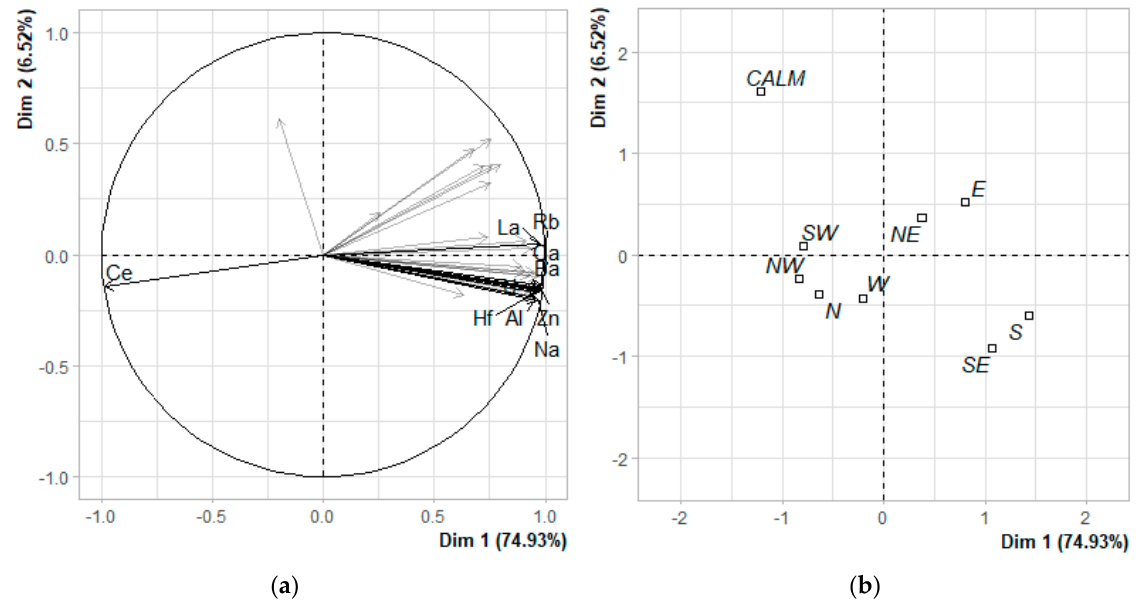
Figure 11. The warm season PCA results for the first two dimensions; ( a ) correlation circle of clr-transformed elemental concentrations; 10 most contributing variables are presented; ( b ) qualitative factor map of the sectors.